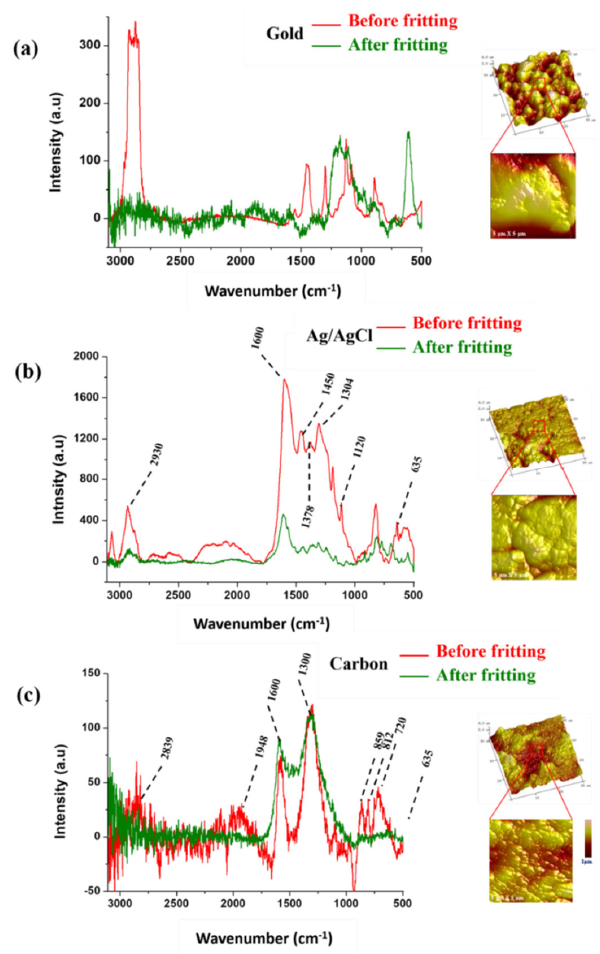
Figure 2. Raman spectra of pastes used for electrodes before and after fritting: ( a ) gold paste; ( b ) Ag/AgCl one; ( c ) carbon one. Corresponding 3D height AFM images (30 μ m × 30 μ m) and zoomed images (5 μ m × 5 μ m) of the gold, Ag/AgCl, and carbon electrodes after fritting (height scale of 1 μ m indicated in ( c )).